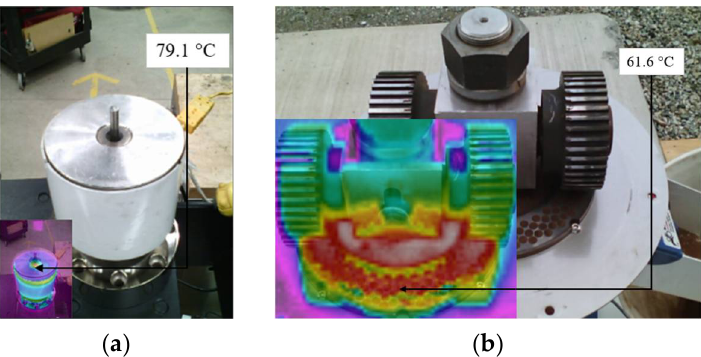
Figure 7. Thermographic image of the system used to produce ( a ) lignin pellets and ( b ) both lignin and softwood bark pellets.